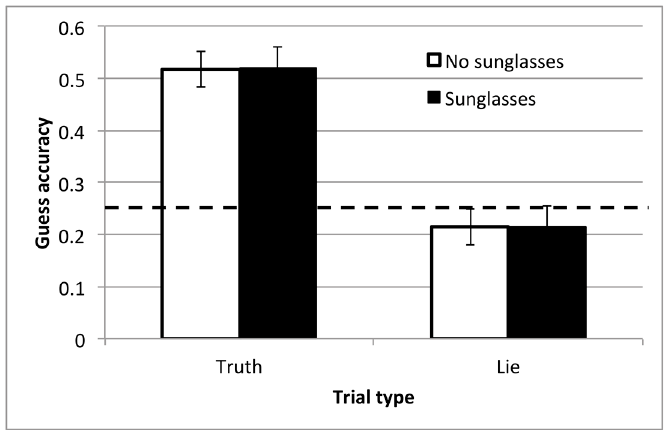
Figure 4. Accuracy from the guess block in Experiment 2. Bars show the mean, with standard error bars, for trials from each block. The dashed line indicates chance performance.